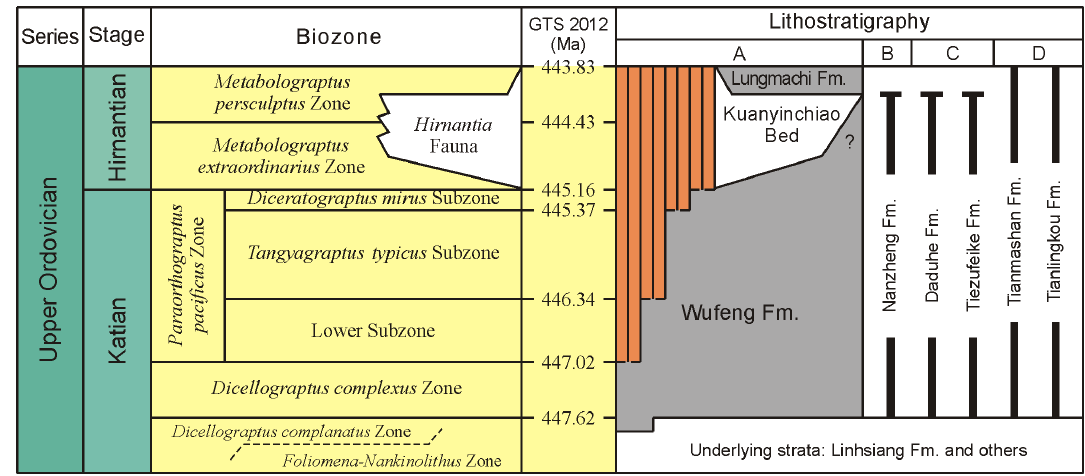
Fig. 1. Katian(cid:150)Hirnantian lithostratigraphy and biozonation in the Upper Yangtze region (modified from Zhang et al. 2014). GTS 2012, The Geologic Time Scale 2012 (see the Ordovician chapter by Cooper & Sadler